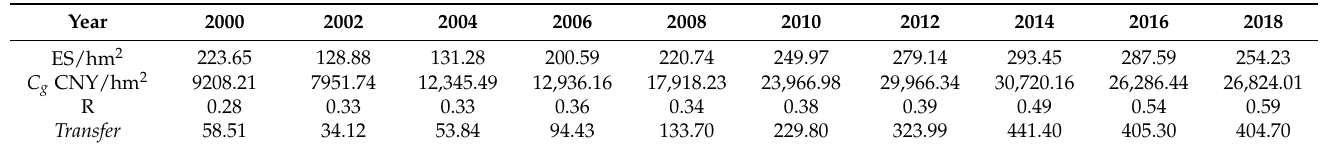
Table 5. Fiscal transfer amount of cultivated land ecological deficit area to the cultivated land ecological surplus area in the Yangtze River Economic Belt from 2000 to